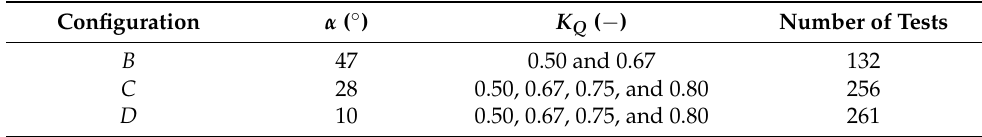
Table 1. Number of tests performed in phase